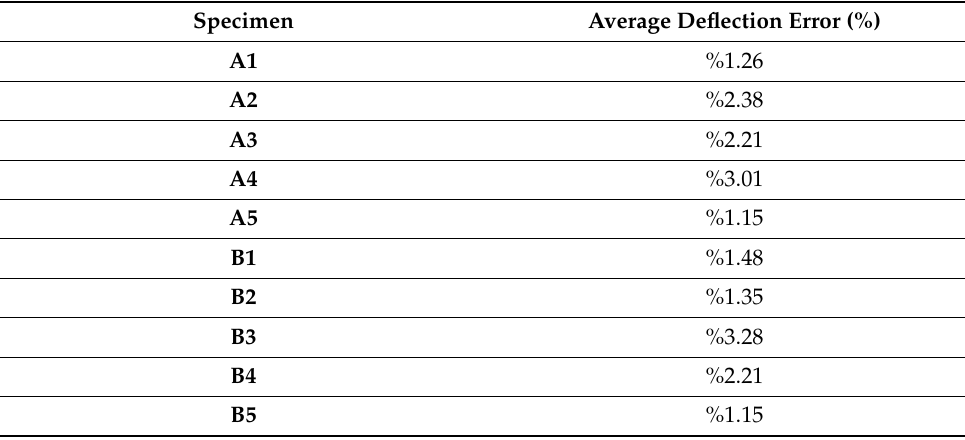
Table 5. The deviation between experimental and FE analysis results.